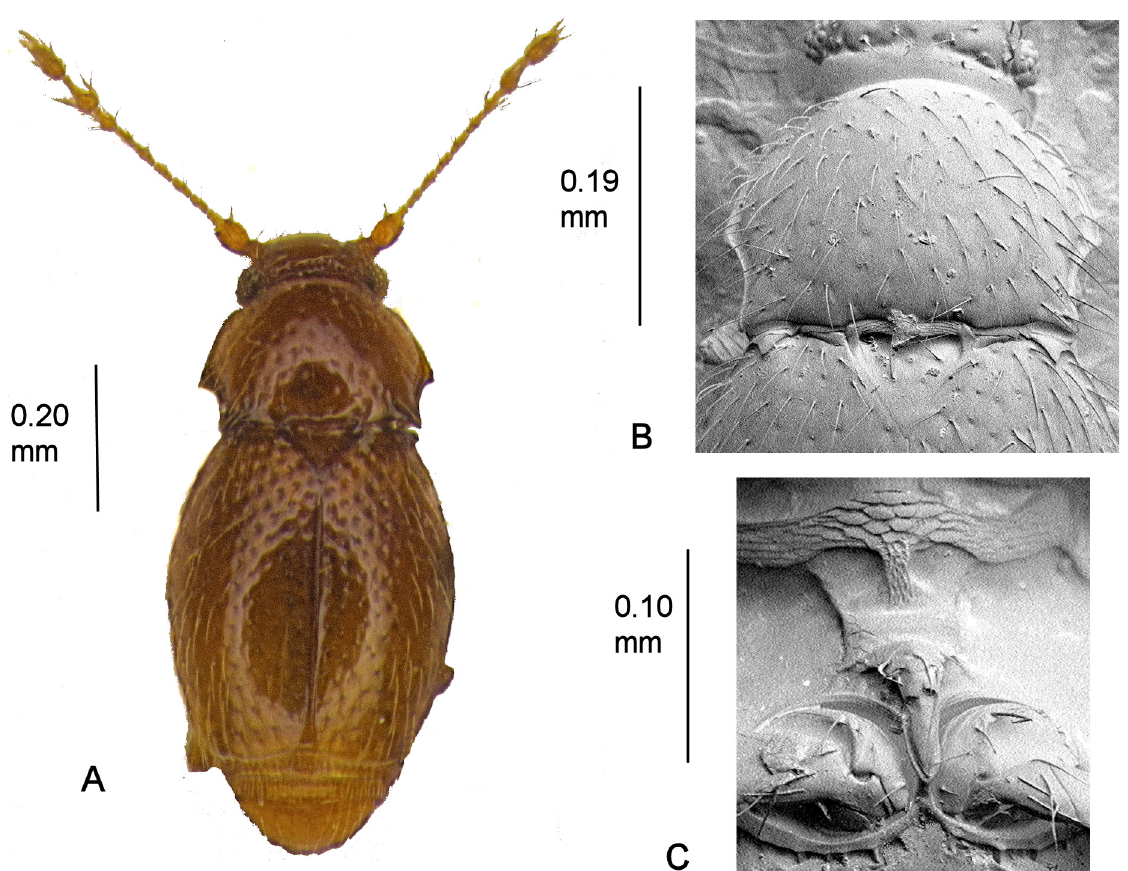
Fig. 93 . Cissidium ibicarense sp. nov. A . Habitus. B . Pronotum, × 505. C . Mesoventrite showing median process of collar, mid-keel and keel, ×